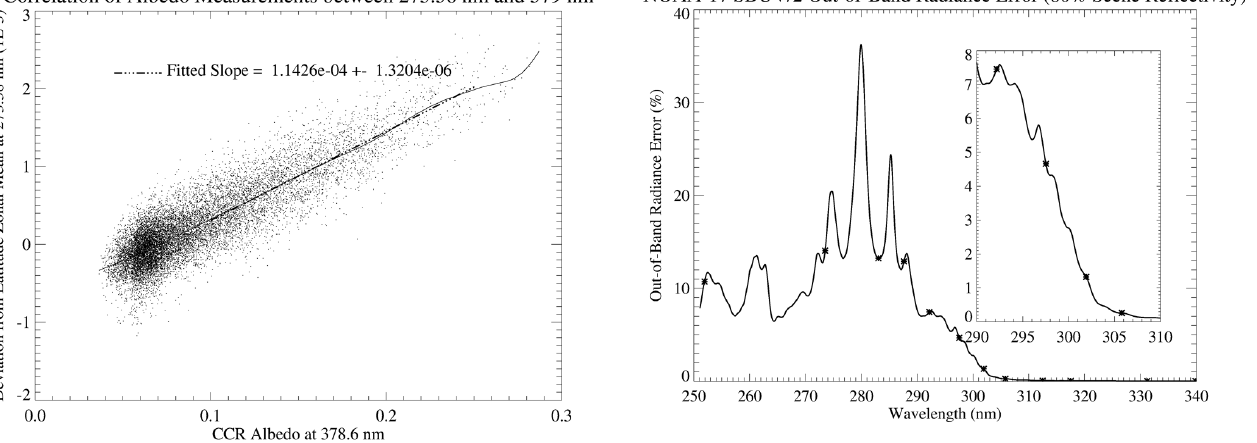
Fig. 17. Calculated out-of-band (OOB) contamination for NOAA- 17 SBUV/2 at solar zenith angle = 30 ◦ , total ozone = 275 DU, reflectivity = 80%. The 12 wavelengths used for normal discrete ozone measurements are indicated by asterisks. The inset panel ex- pands the 290–310nm wavelength